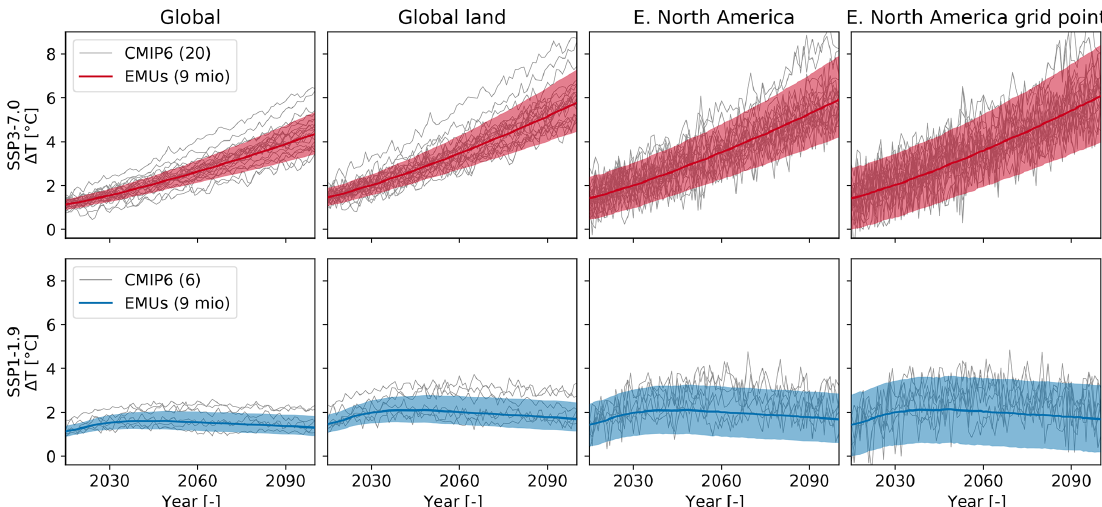
Figure 6. Temperature anomaly projection distributions for the emulated globally constrained probabilistic MAGICC–MESMER ensembles and actual ESM simulations averaged across different spatial scales: global, global land, eastern North America, and a single grid point within eastern North America for a high-emission (SSP3-7.0) and low-emission (SSP1-1.9) scenario. For the MAGICC–MESMER ensemble, the median and the 90% range (5th–95th percentile) of the temperature anomaly distribution are shown in color. For the ESMs, a single simulation per available ESM for that emission pathway is shown in gray.